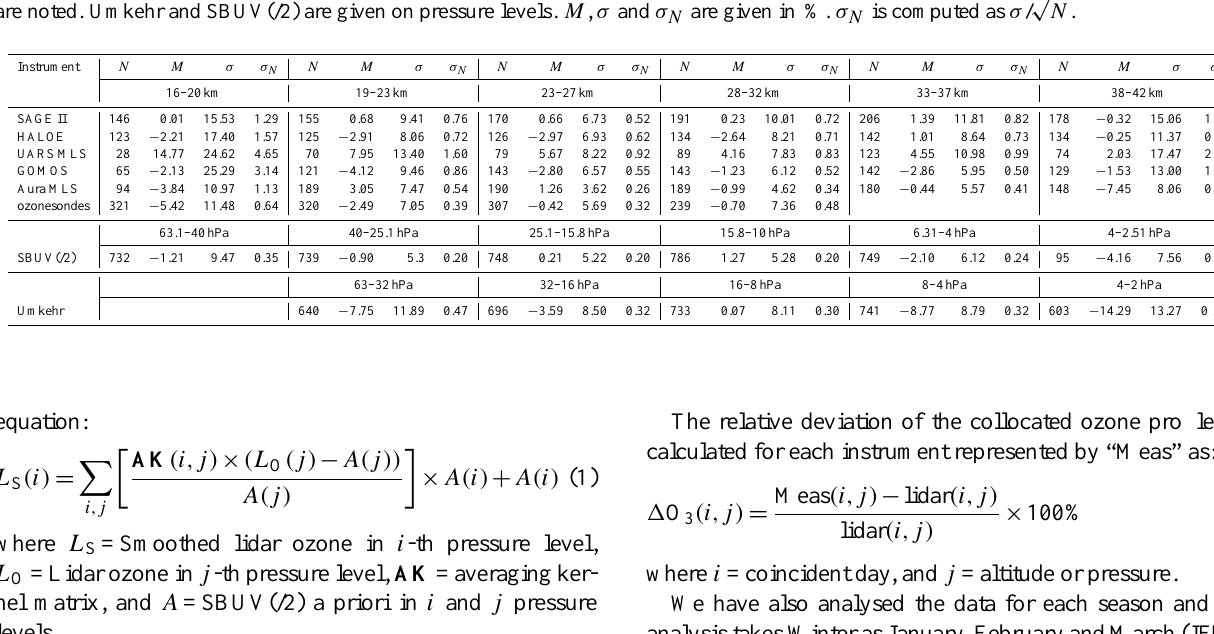
Table 2. Statistics derived from coincident measurements of lidar ozone at OHP with various observations. Number of matching events (N) , mean (M) , standard deviation ( σ ), and standard error ( σ N ) calculated from the time series of daily variations (%) for the selected altitudes are noted. Umkehr and SBUV(/2) are given on pressure levels. M , σ and σ N are given in %. σ N is computed as σ /